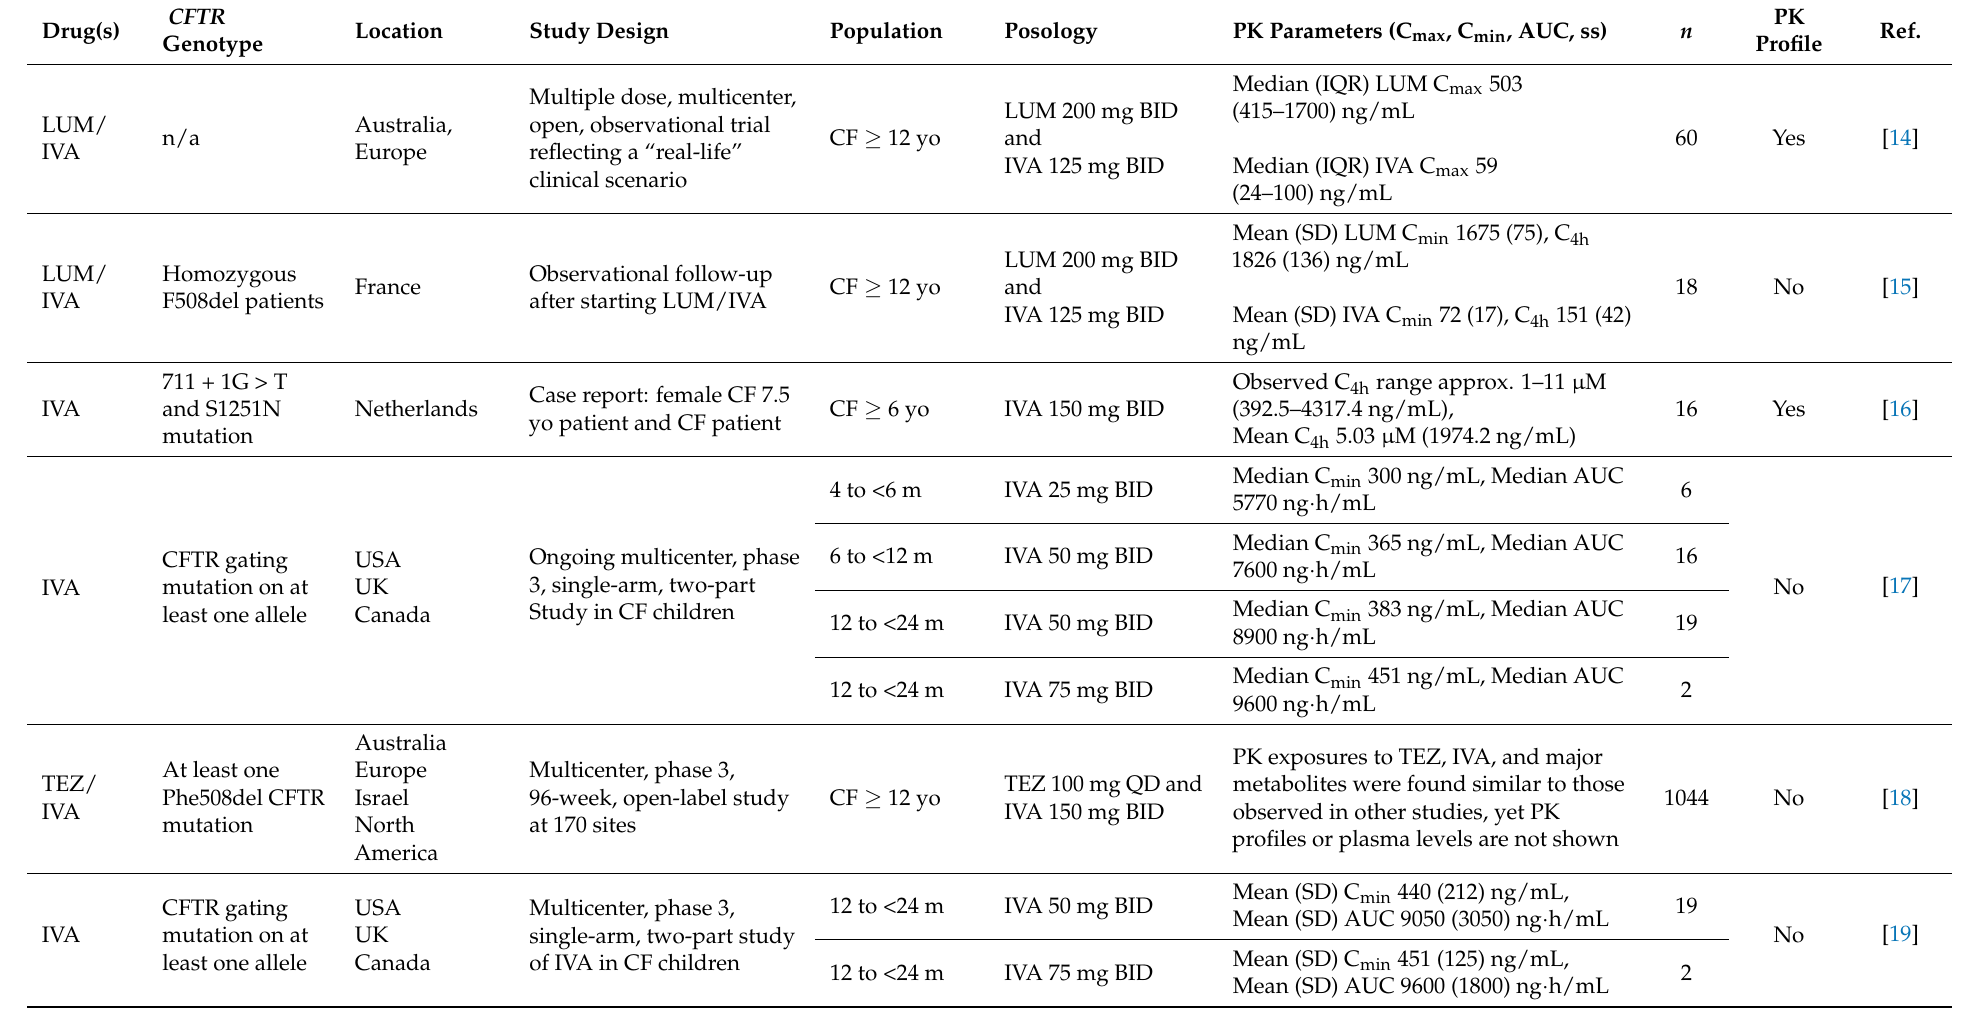
Table 3. CFTR modulator multi-dose exposition from real-world setting, or trials published after the latest caftor registration (i.e., 2021), or any studies including children below the minimum age recommended in the registration